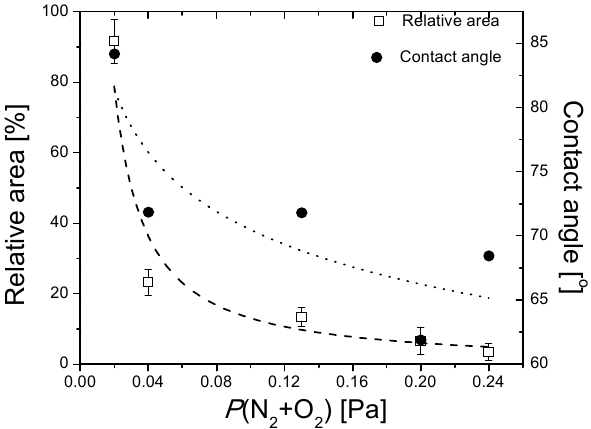
Figure 16. Relative surface area of the bacterial colonies and contact angle, as a function of the partial pressure.